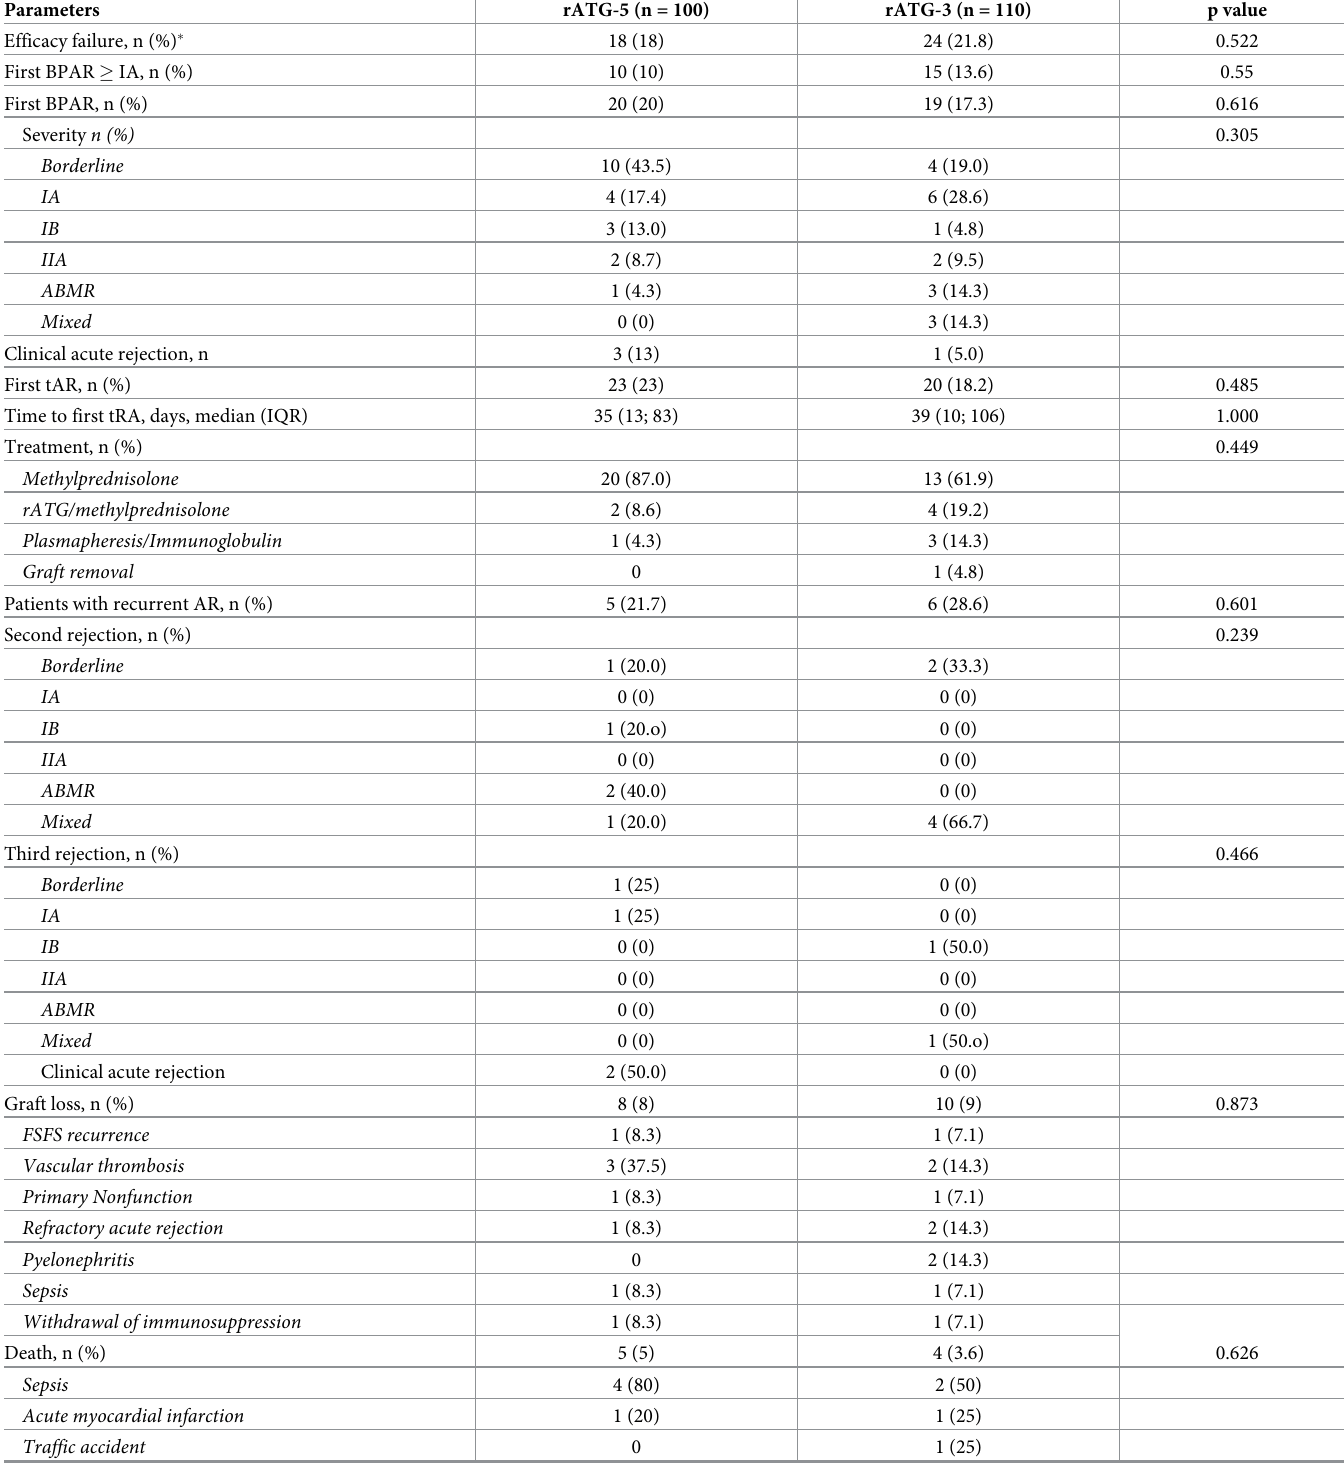
Table 3. Efficacy parameters at 12